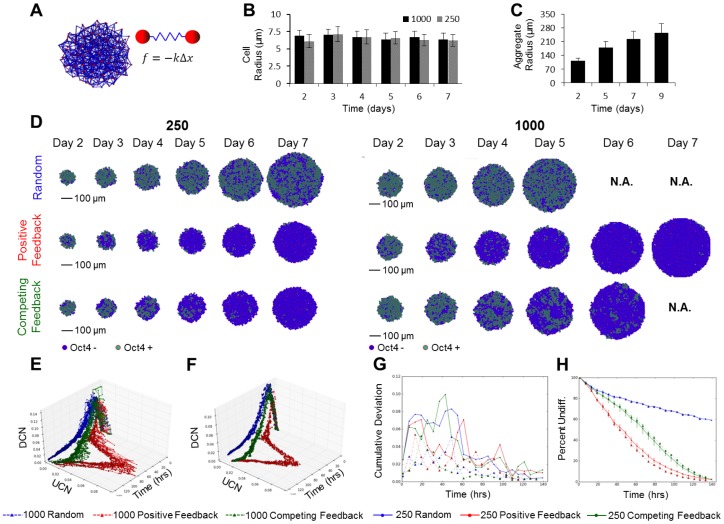
The effects of cell division on spatial pattern trajectories.(A) Mass spring schema for modeling cellular division and adhesion. (B) Coulter coulter data showing the radius of stem cells from embryoid bodies and how they change over the 6 day differentiation time course. (C) Estimated sizes of embryoid bodies used to estimate growth rates. (D) Representative virtual slices of simulated 250 and 1000 cell dividing embryoid bodies for the three different rules. Oct4+ cells are shown in teal and Oct4− cells in blue. UCN, DCN time plot trajecory for the 250 cell EBs (E) and 1000 cell EBs (F). (G) Summation of the variance in the UCN, DCN trajectories. (H) The percent of undifferetiated cells as a function of time.